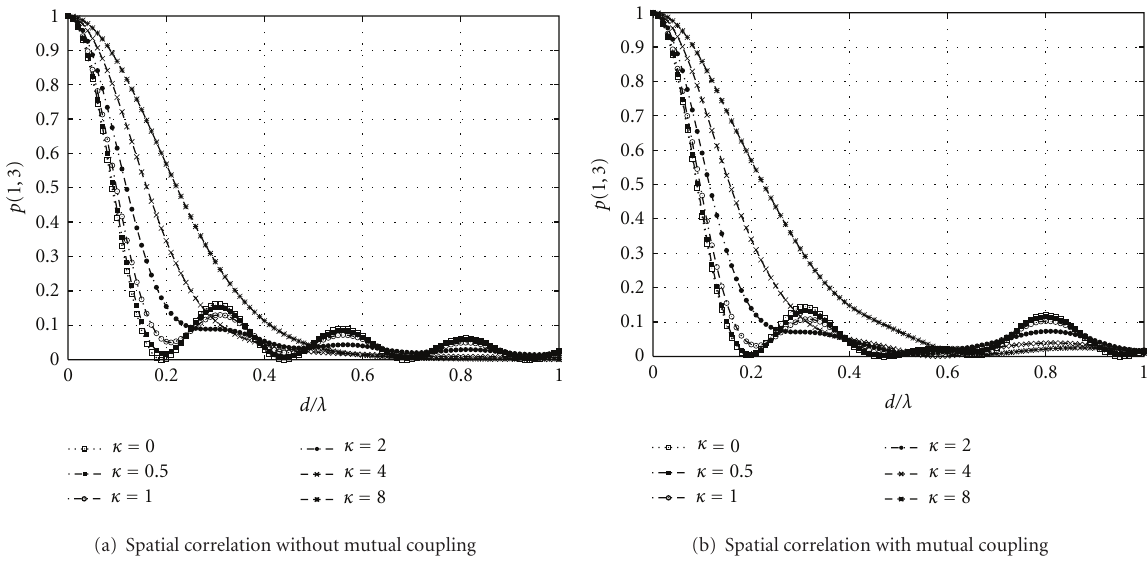
Figure 3: Spatial correlation between elements 1 and 3 for a linear array with six elements, and di ff erent values of the parameter κ , with φ p = 30 ◦ , as a function of d/λ .